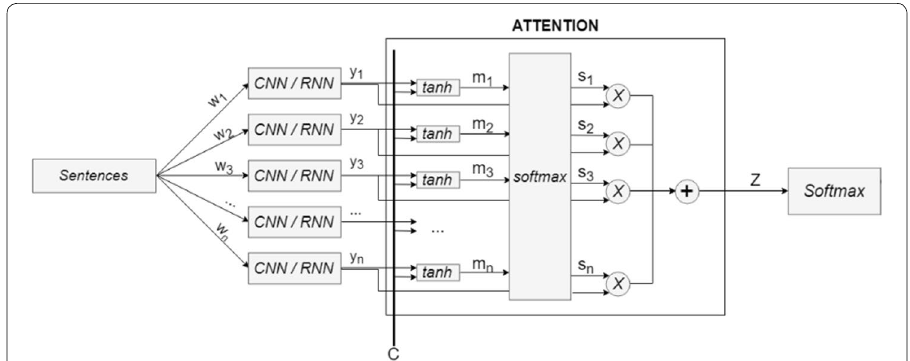
Fig. 4 Attention mechanism attached to deep